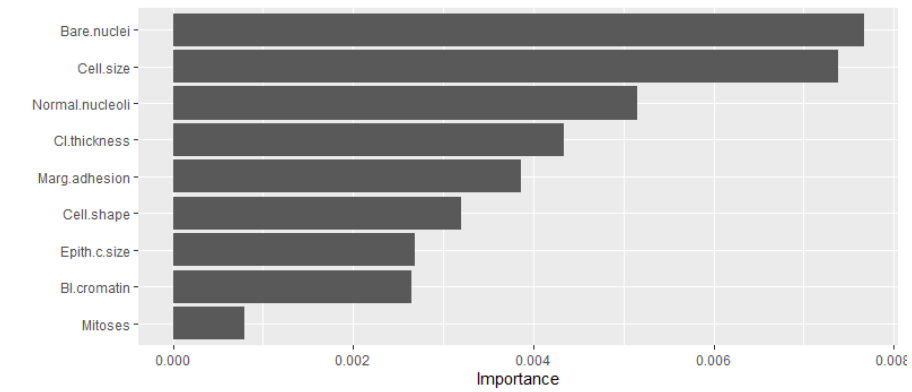
Figure 25. SVM important variables for the breast cancer data.